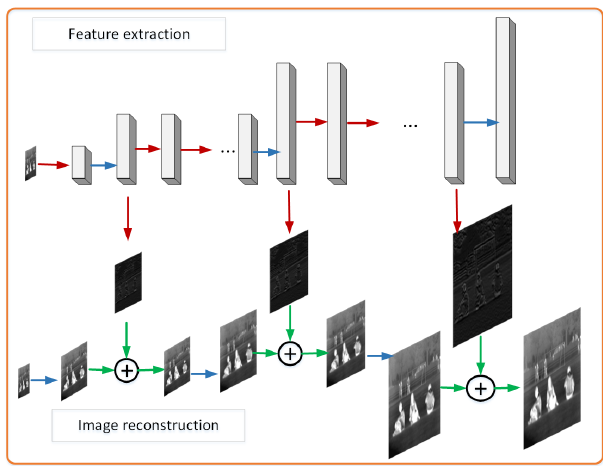
Figure 1. LapSRN Network